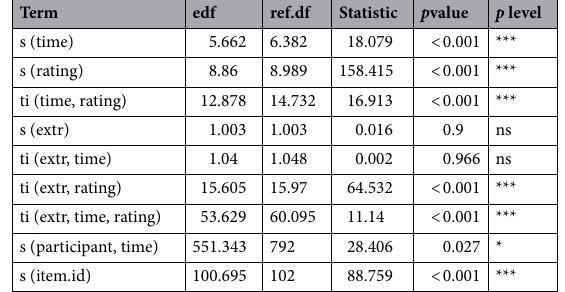
Table 7. Summary output for the GAMM modelling participants’ pupil sizes in response to semantic anomalies and with their Extraversion score as a